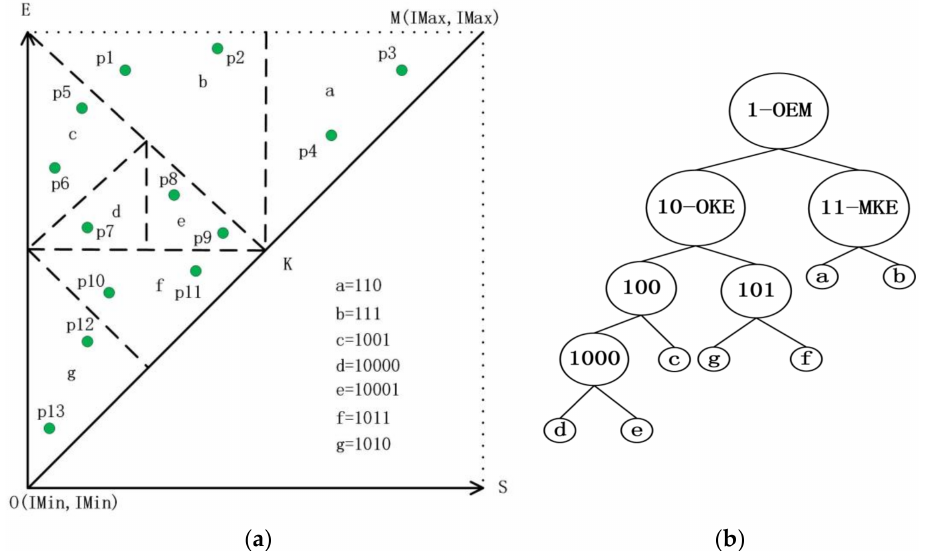
Figure 7. TD-tree’s partition strategy (TDPS) and triangle binary tree. ( a ) TD-Tree’s triangle decomposition; ( b ) Triangle binary tree with